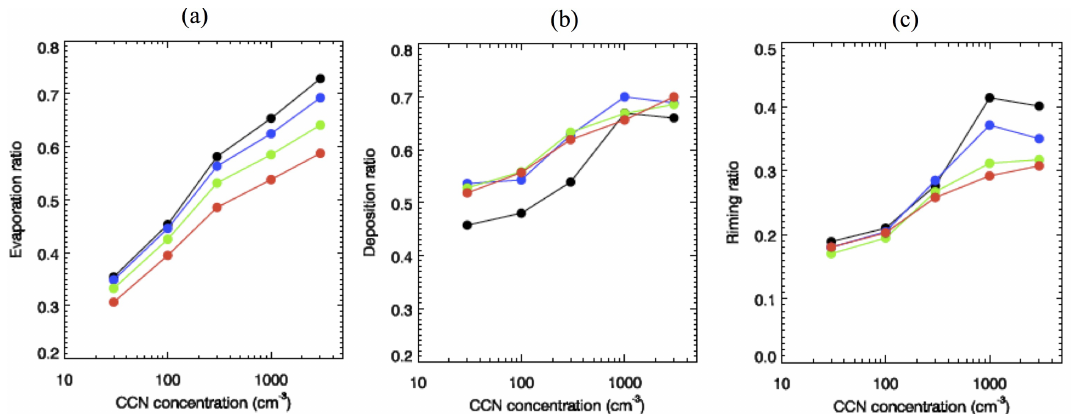
Figure 17. Same as Fig. 5, except for the